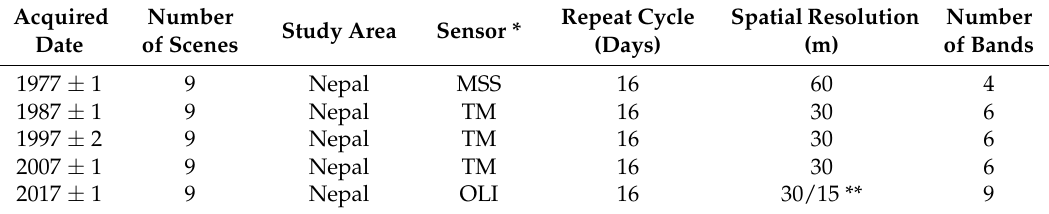
Table 1. Landsat data used for this